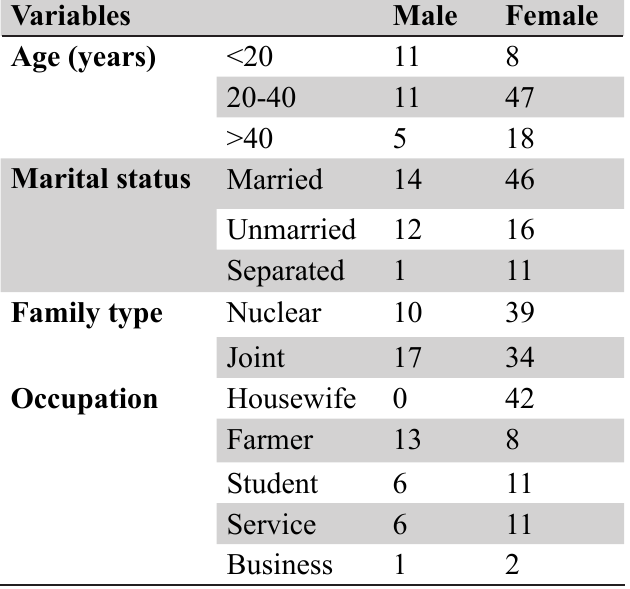
Table 1. Socio‑demographic profile of intentional self‑harm